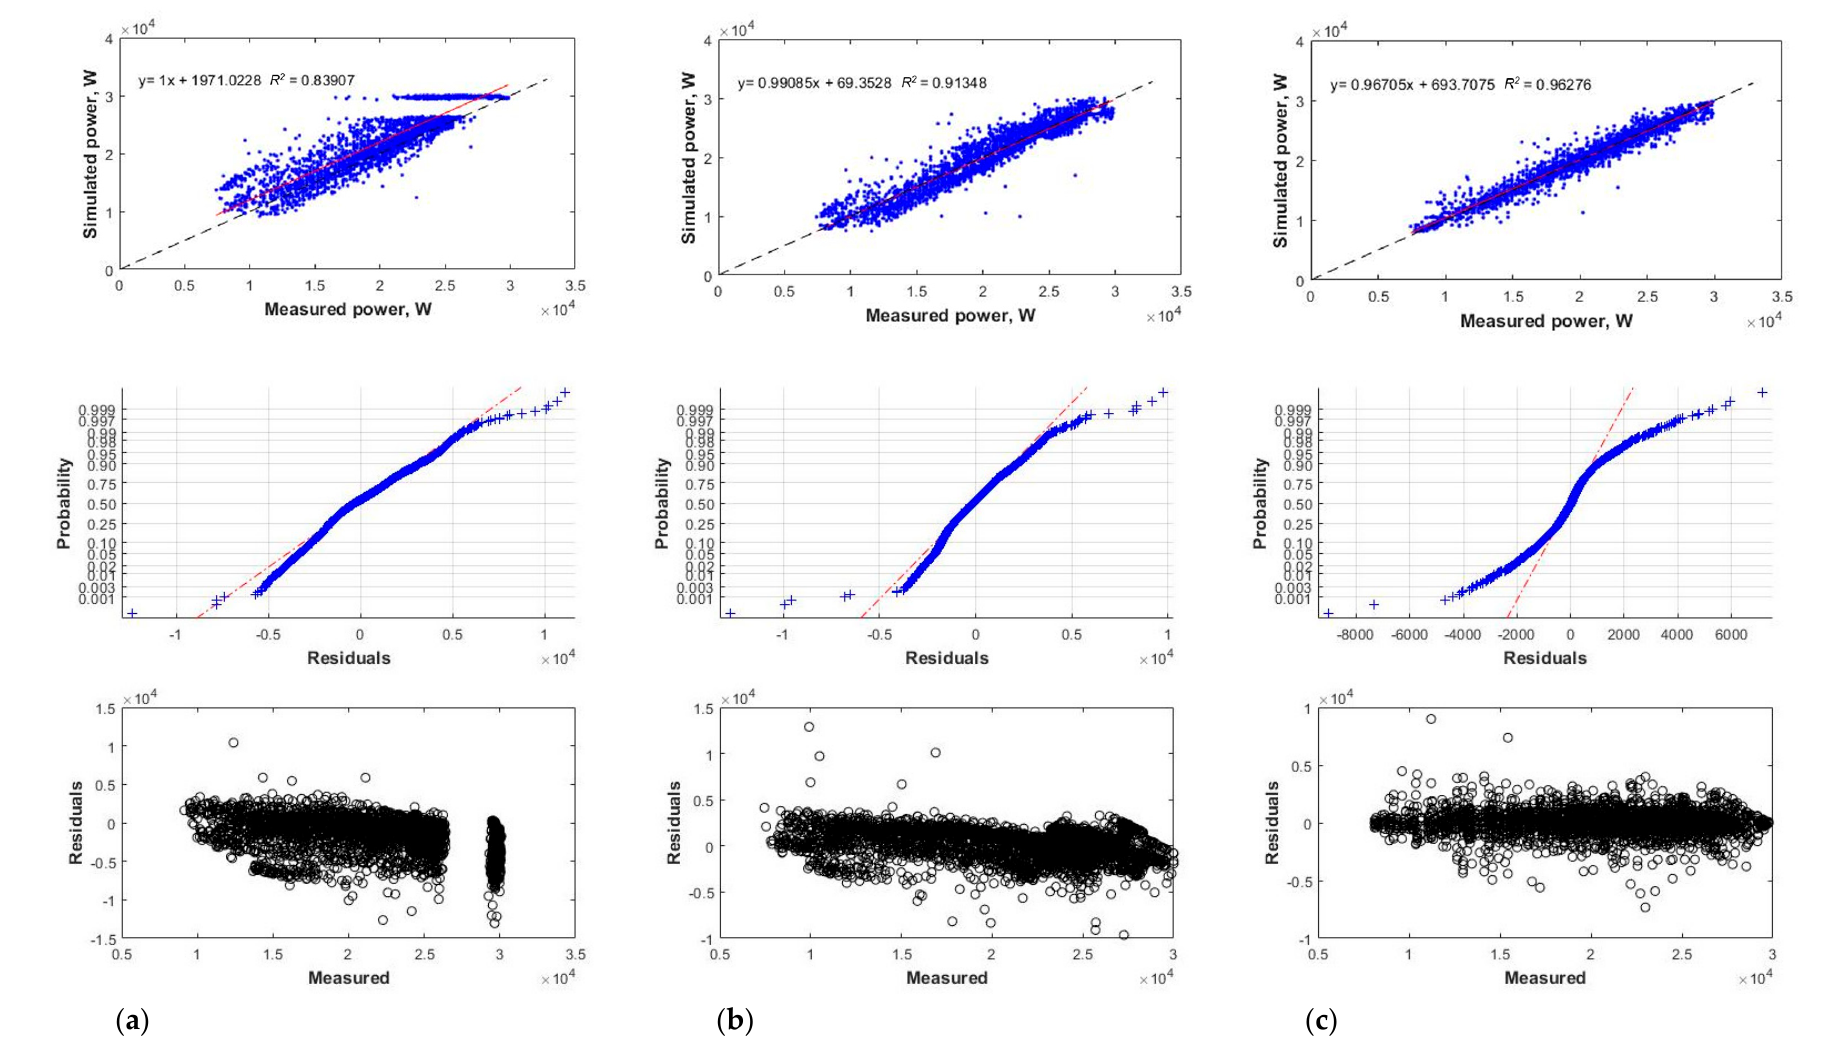
Figure 3. Statistical adjustment of the Simplified Model ( a ), I-Solar model ( b ) and AI-Solar model ( c ), adjustment to the normal of the normal of the residuals and homoscedasticity.